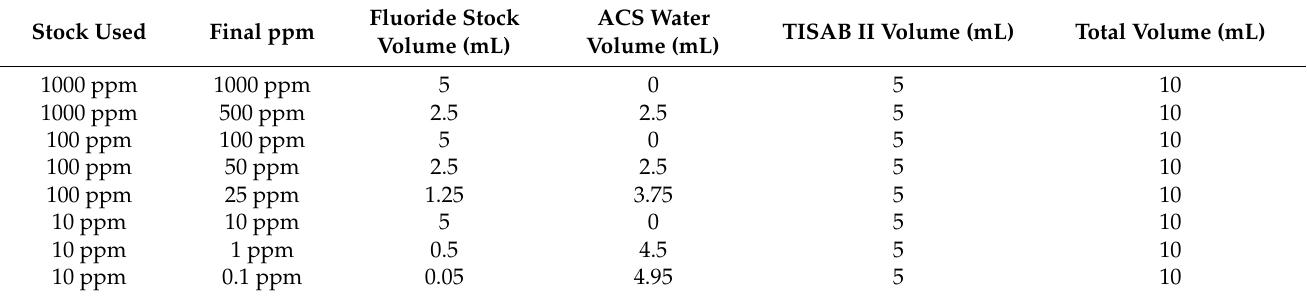
Table 2. Dilutions for standards